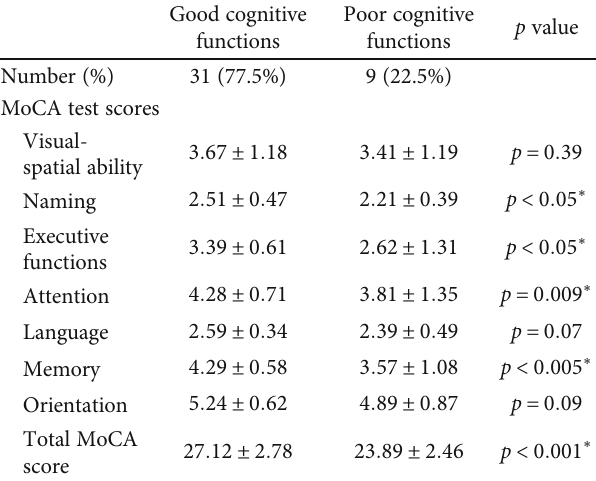
Table 1: Classi fi cation of patients of SAH according to cognitive impairment. Good cognitive Poor cognitive p value functions functions Number (%) 9 (22.5%) MoCA test